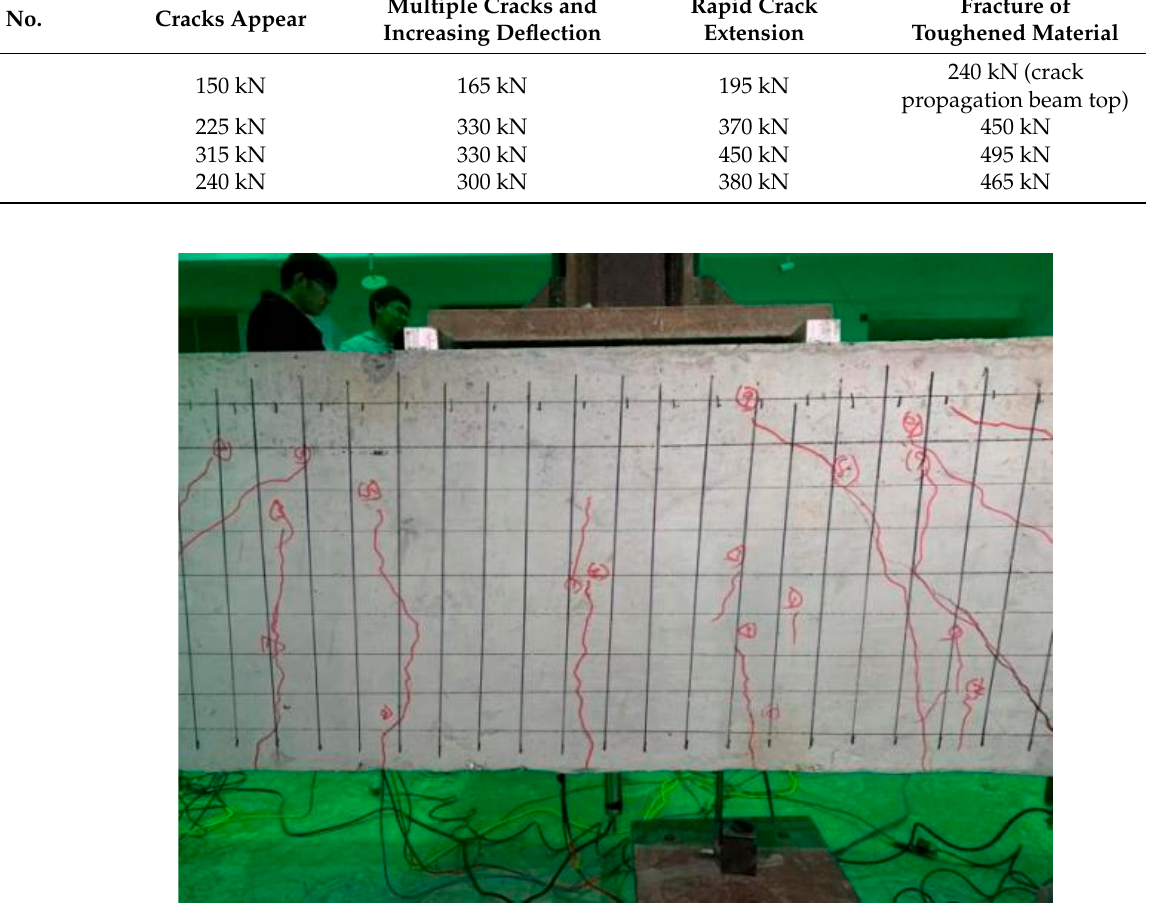
Figure 8. Crack pattern of L0 beam.